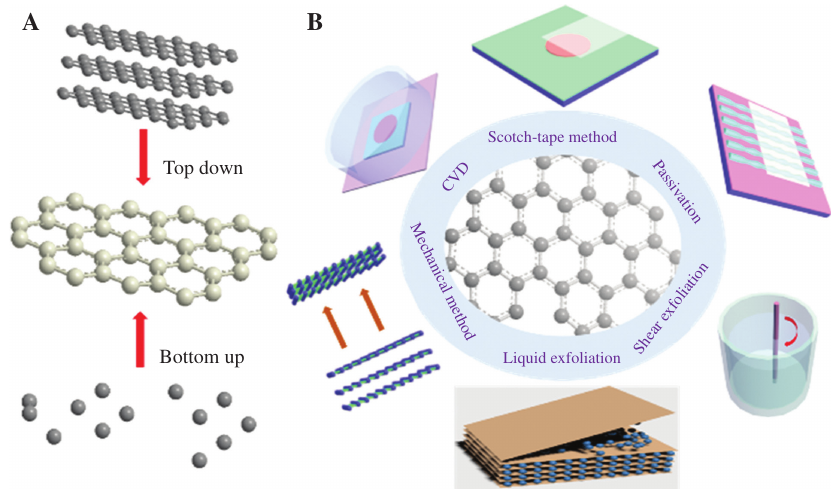
Figure 2: Schematic of the fabrication method of 2D materials. (A) Two main approaches: top-down exfoliation and bottom up growth. (B) Detailed fabrication